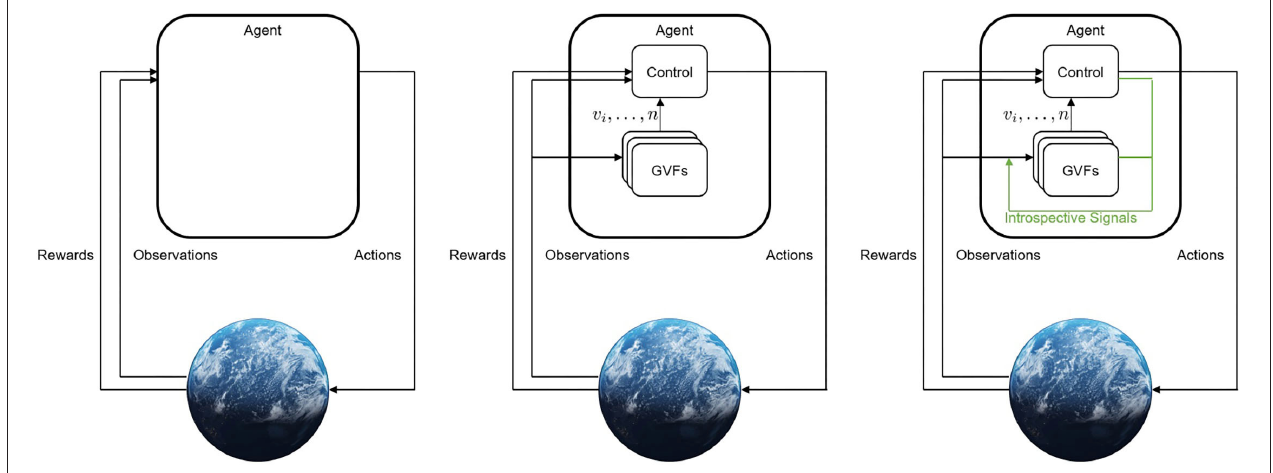
FIGURE 1 | From left to right: (1) Classical RL where an agent takes actions and receives a reward and observations from its environment; (2) a setting where an agent maintains n GVFs about its environment to augment its observations with; (3) a setting where the agent monitors its internal learning process to further inform its estimates. Additional signals that are produced during the process of learning can be used to inform the GVFs themselves, allowing the learner access to its internal